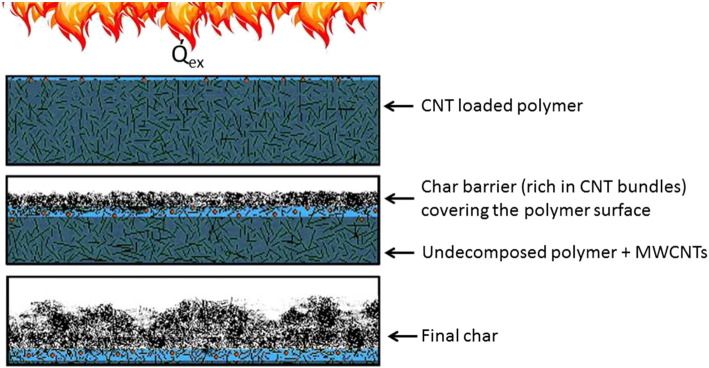
MWCNTs as fire protection promoters (adapted from (Kashiwagi et al., 2005b)).